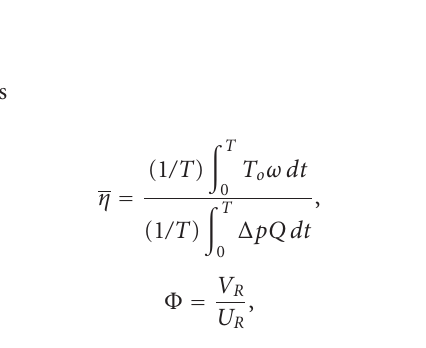
Figure 11: E ff ect of di ff user setting angle of outer guide vane on turbine characteristics under sinusoidal flow conditions ( θ ni = θ no = 15 ◦ ). (a) Mean e ffi ciency. (b) Peak e ffi ciency.